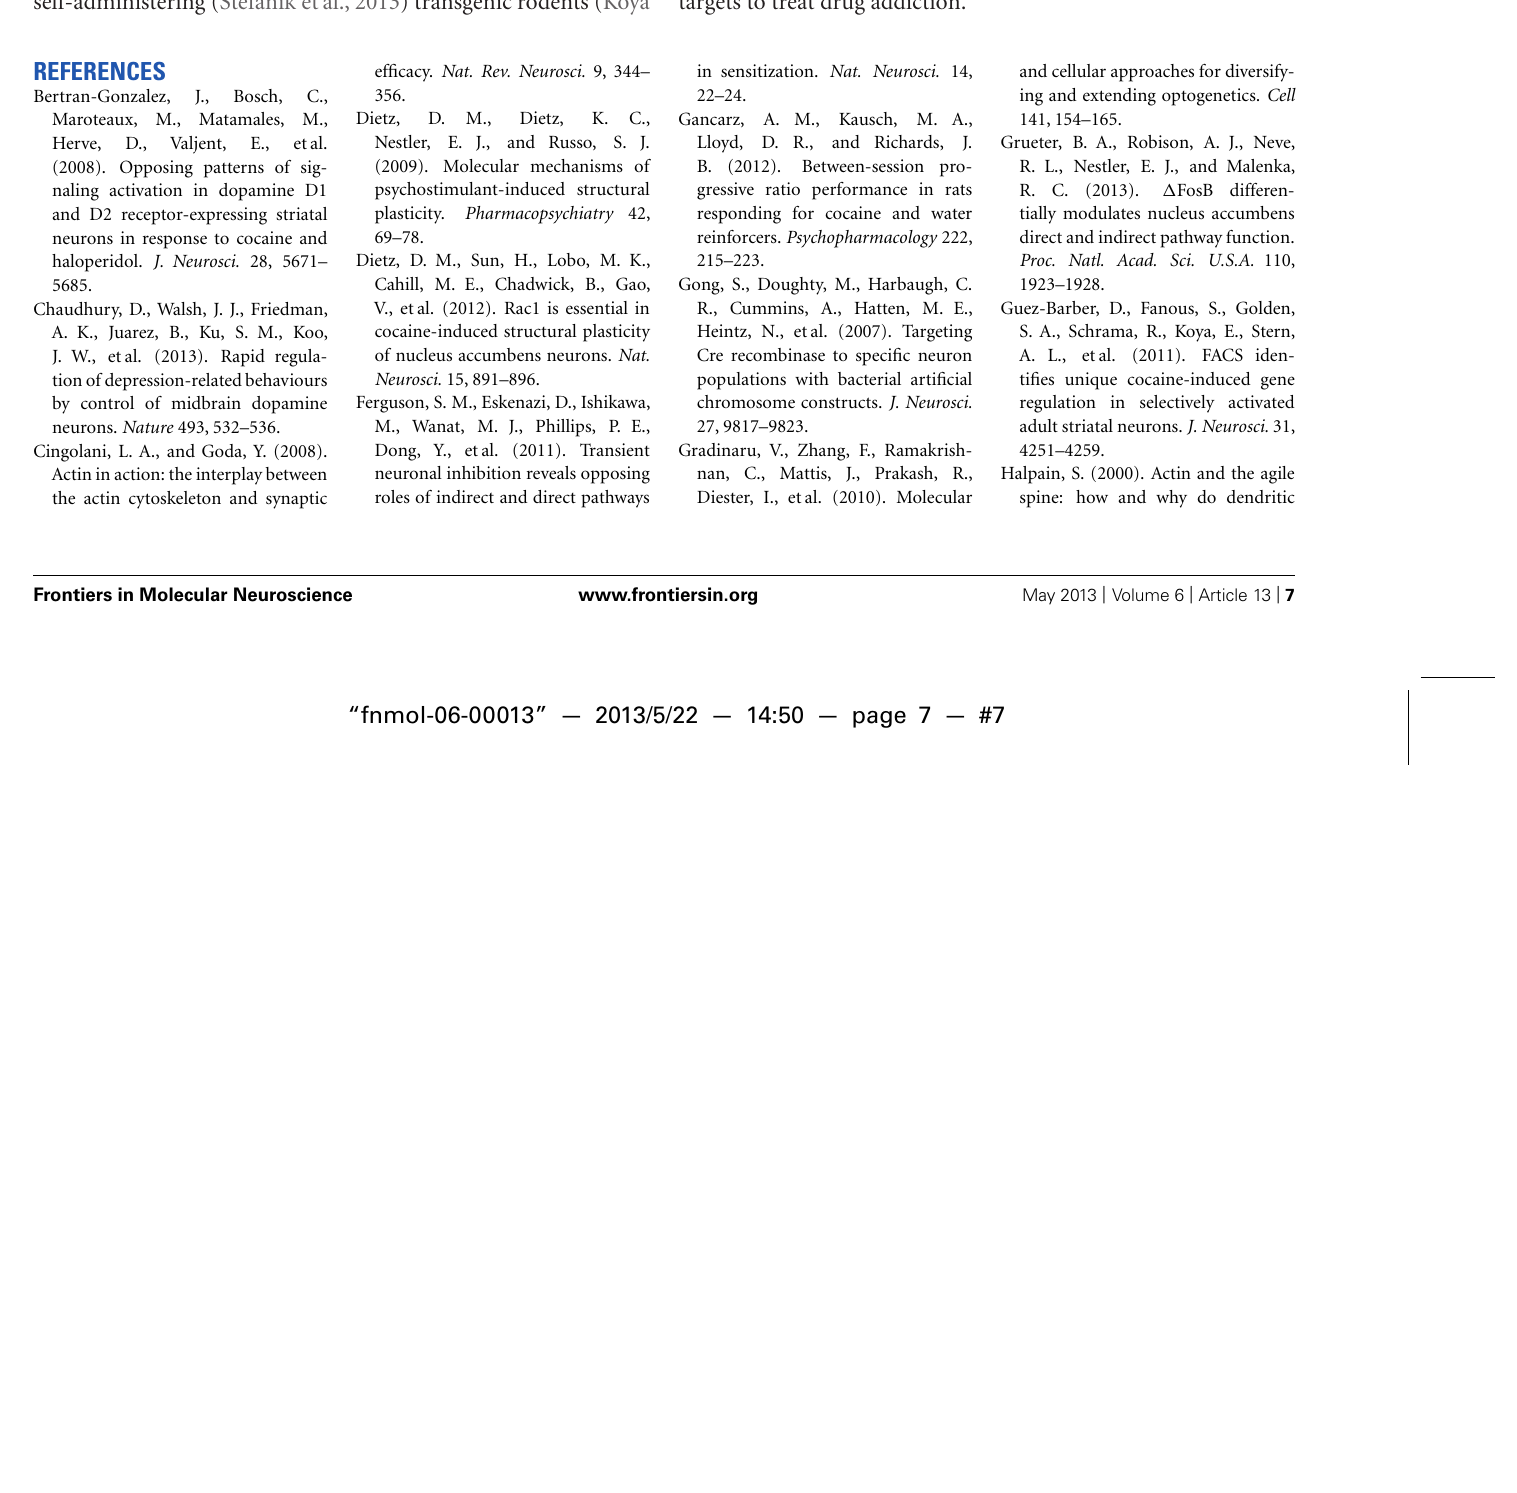
F (15,85) = 13.03, p < 0.0001, post hoc test, * p < 0.05.) (B,C) Tiam1 mRNA and protein is significantly down-regulated in the NAc of the cocaine AAV-DIO-EYFP group compared to the saline AAV-DIO-EYFP and AAV-DIO-eNpHR3.0-EYFP saline groups. Inhibition of D1-MSNs in the AAV-DIO-eNpHR3.0 cocaine group reversed the bluntedTiam1 cocaine response (mRNA: n = 4–7 per group, two-way ANOVA, interaction, F (1,16) = 7.64, p < 0.05, post hoc test, * p < 0.05; protein: n = 4–7 per group, two-way ANOVA, group effect, F (1,16) = 6.24, p < 0.05, drug effect, F (1,16) = 4.60, p < 0.05, post hoc test, * p <